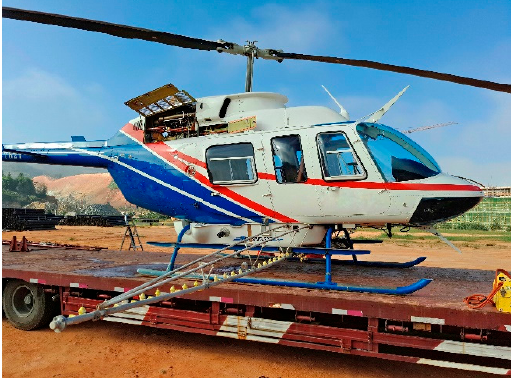
Figure 4. Bell206L4 helicopter for spraying operation. Table 2. Technical parameters of Bell206L4 helicopter and main performance indexes of equipped equipment.